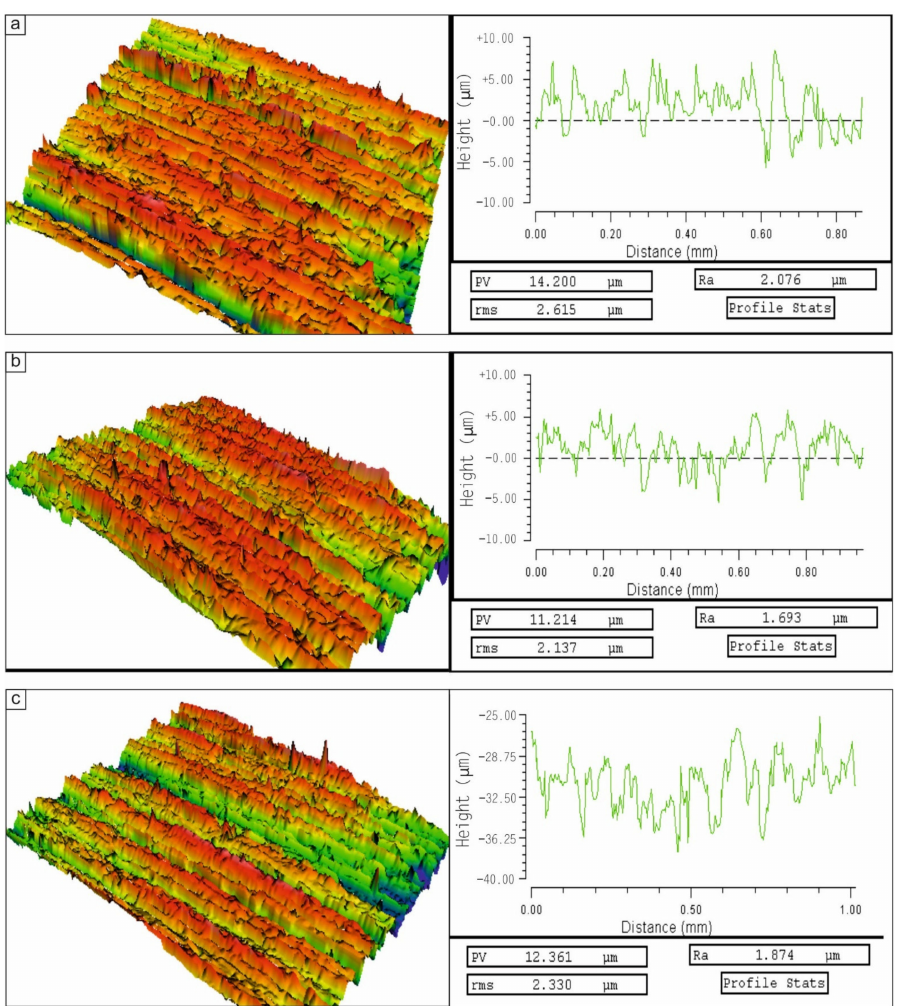
Figure 6. The surfaces of specimens after friction: pure titanium ( a ), Ti-41Al-7Cr cladding layer ( b ), Ti-41Al-7Ta cladding layer ( c ) after a friction test against fixed abrasive particles. Images and graphs were obtained using optical